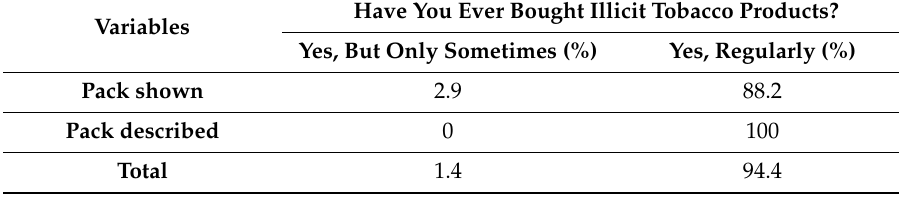
Table 7. Proportion of smokers who showed or described illicit cigarette packs according to self-reported frequency of purchasing illicit tobacco